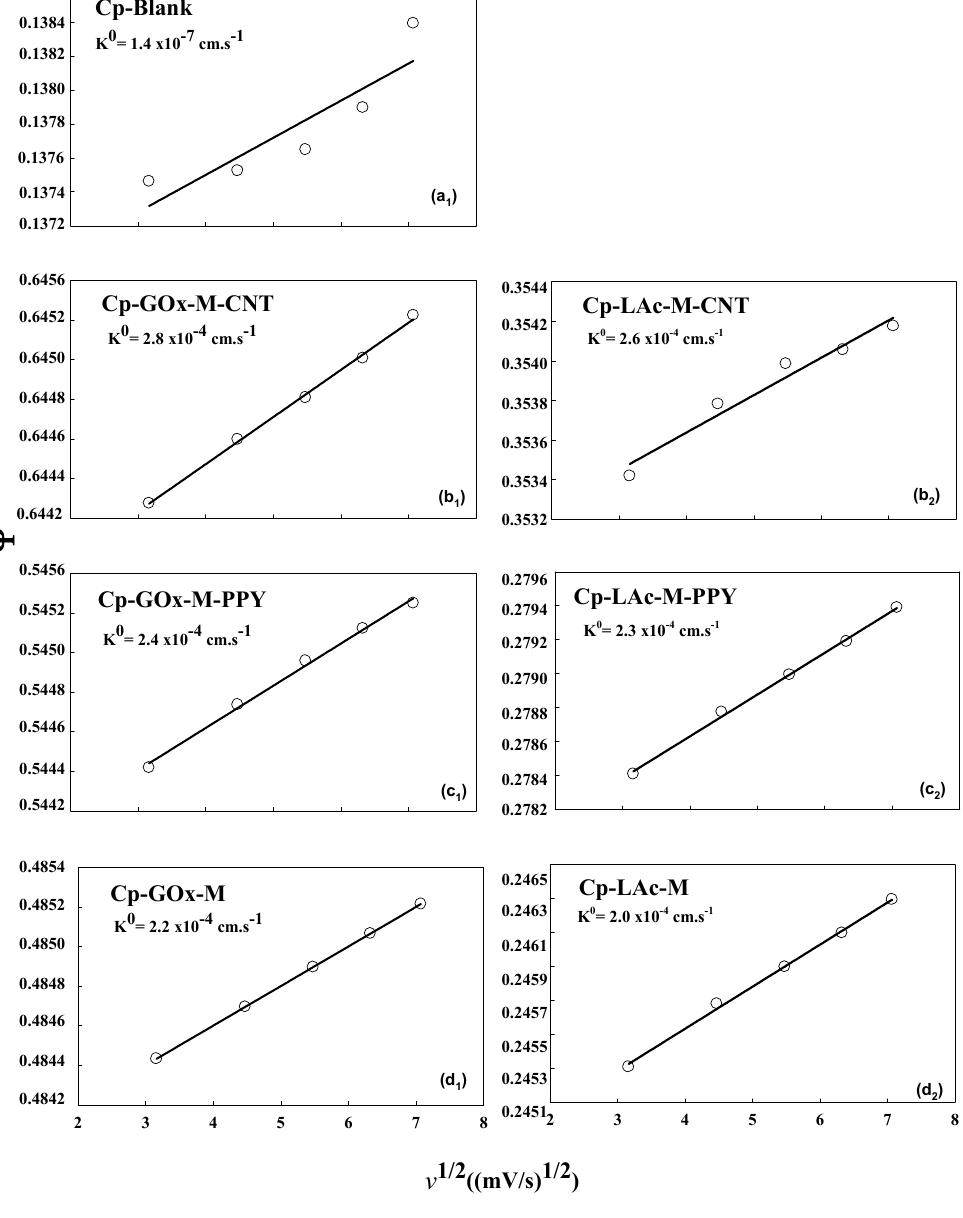
Figure 3. Plot of ψ vs. υ 1 / 2 for ( a 1 ) carbon paper, ( b 1 – d 1 ) bioanode electrode, and ( b 2 – d 2 ) biocathode electrode at a scan rate of 10–50 m υ /s.